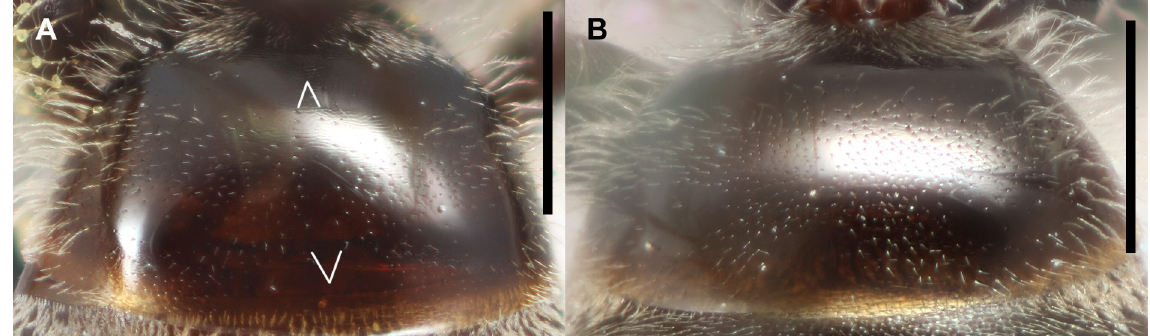
Fig. 90. T1 disc. A . Lasioglossum tegulariforme (Crawford, 1907), ♀, with median impunctate line about 1 OD wide (brackets). B . L. angelicum sp. nov., ♀, uniformly punctate. Scale bars = 0.5